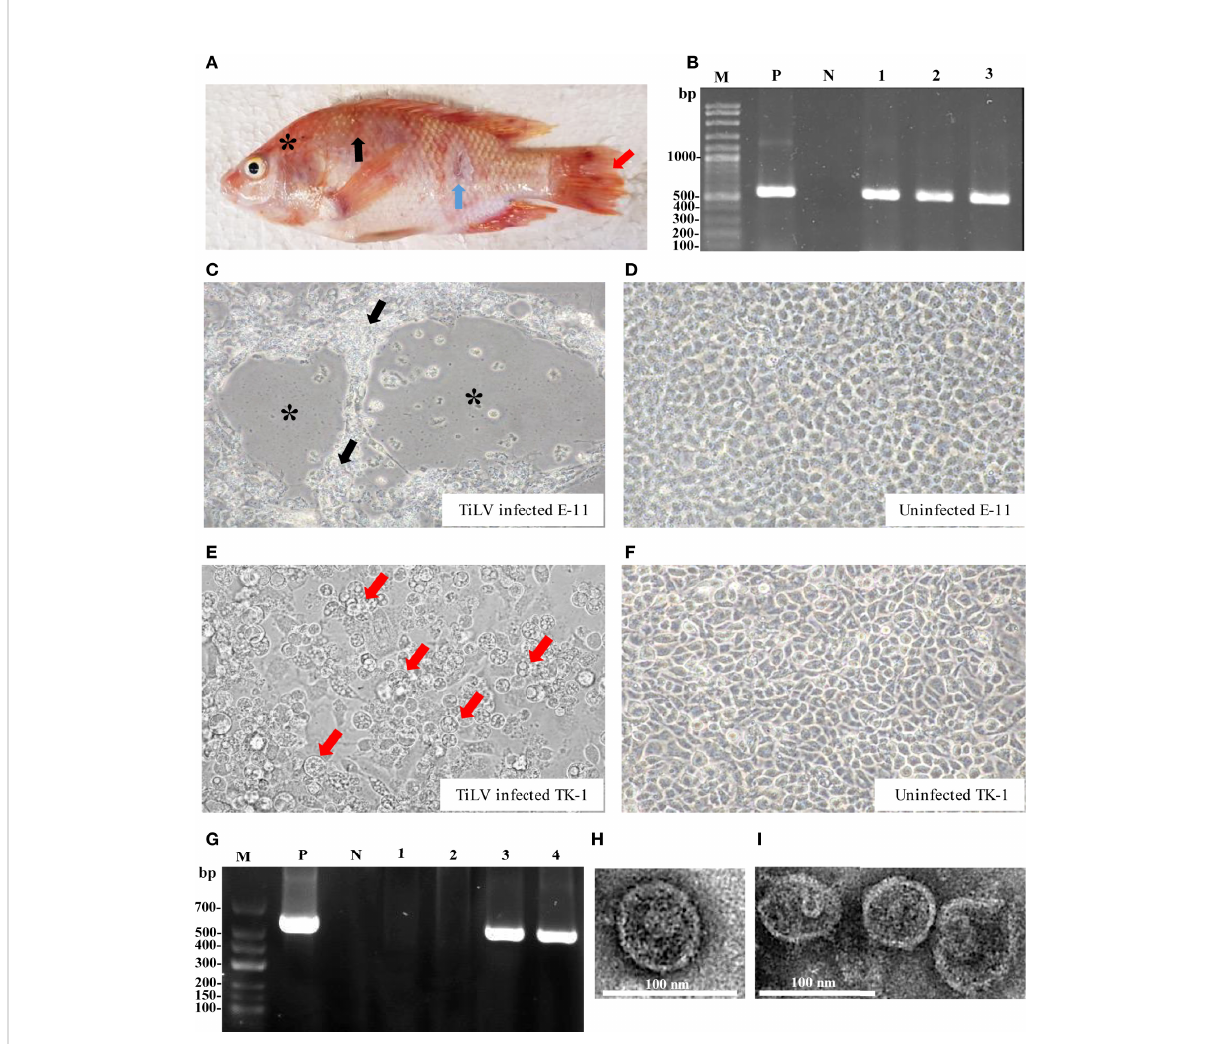
FIGURE 1 TiLV detection of infected tilapia organs, infected cell cultures and transmission electron microscope (TEM) analyses. (A) Clinical signs of infected fi sh include skin redness and congestion around the eye and head (asterisk), severe skin hemorrhage (black arrow), skin erosion (blue arrow) and fi n rot (red arrow). (B) Infected fi sh were screened for TiLV infection from different organs using RT-PCR and speci fi c PCR products approximately 500 bps were observed. Lane M: DNA marker; Lane P: positive control; Lane N: negative control; Lanes 1-3: brain, liver and spleen tissues from infected fi sh, respectively. (C) E-11 infected cells revealed CPEs with plaque formation (asterisk) and syncytial formation (black arrow) at 7 days post infection (dpi). (D) Uninfected E-11 cells. (E) TK-1 infected cells revealed CPEs with cell swelling, vacuolated appearance (red arrow) followed by cell detachment at 7 dpi. (F) Uninfected TK-1 cells. (G) Detection of TiLV from E-11 and TK-1 infected cells by RT-PCR. Lane M: DNA marker; Lane P: positive control; Lane N: negative control; Lanes 1-2: uninfected E-11 and TK-1, respectively; Lanes 3- 4: infected E-11 and TK-1 cells, respectively. (H, I) TEM micrograph of the puri fi ed TiLV from infected TK-1 culture supernatant that showed isolated virion (H) , and aggregated virions in small group (I)